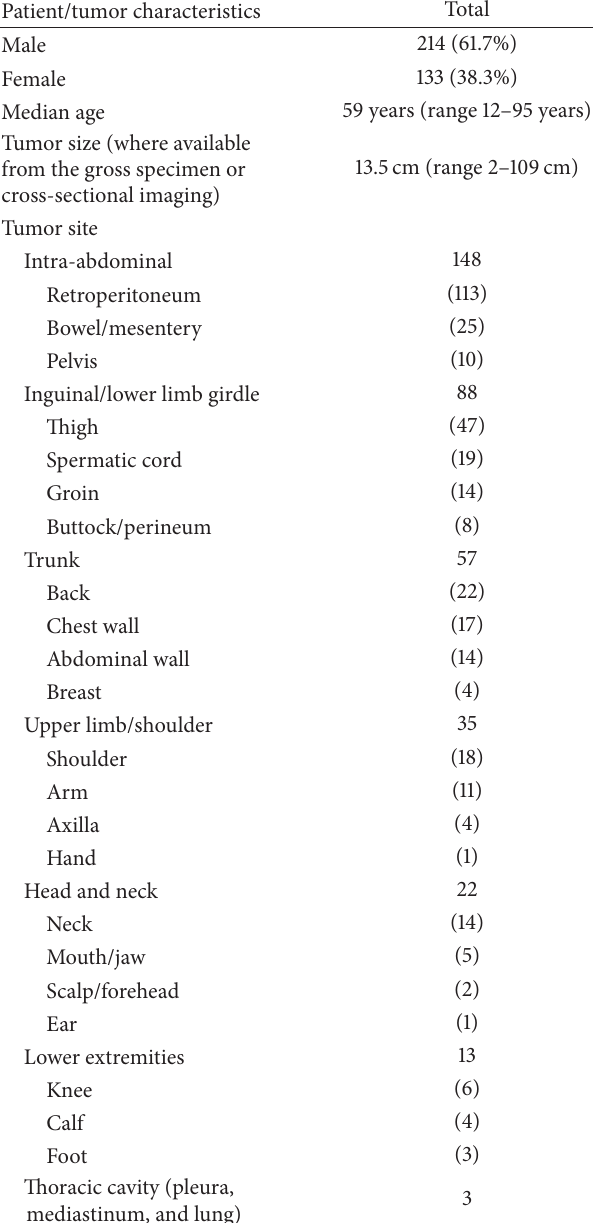
Table 1: Patient and tumor